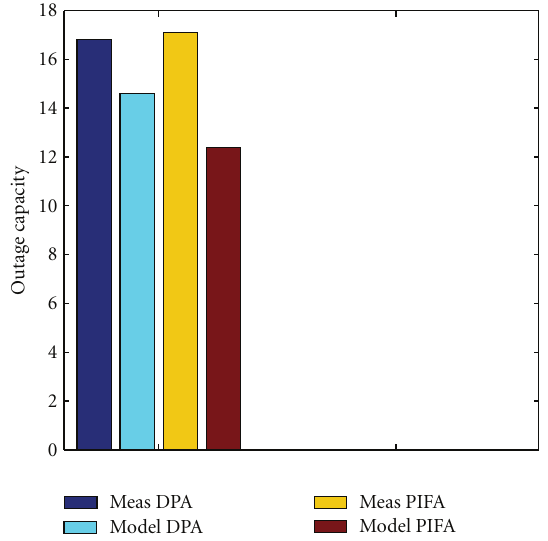
Figure 7: 5% outage channel capacity at SNR 25 dB at the di ff erent spots.